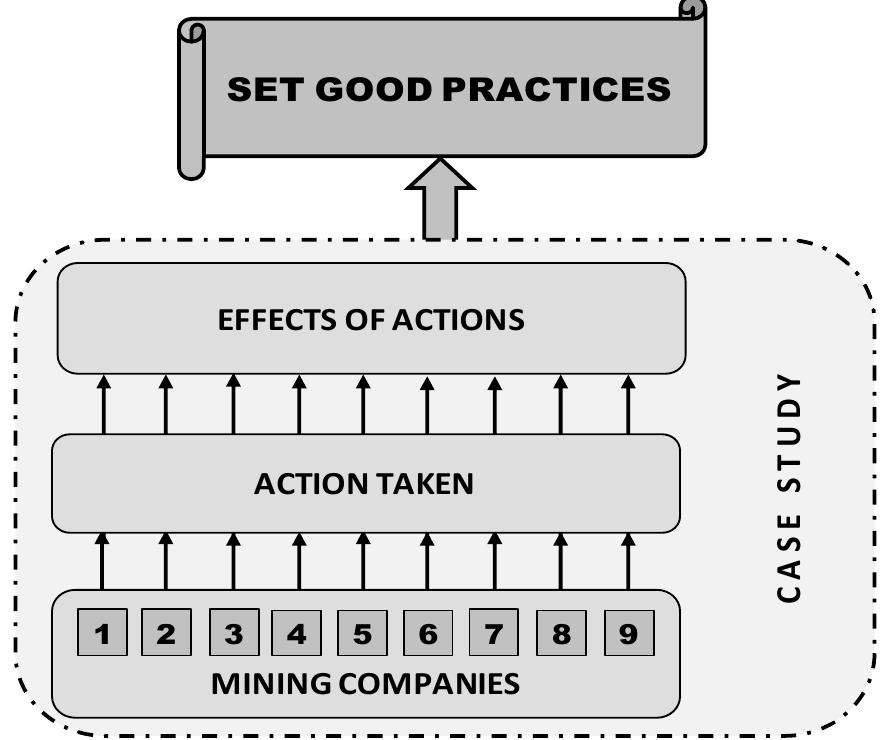
Figure 2. Object and expected result of the case study. Source: author’s own elaboration based on the research carried out in mining companies.